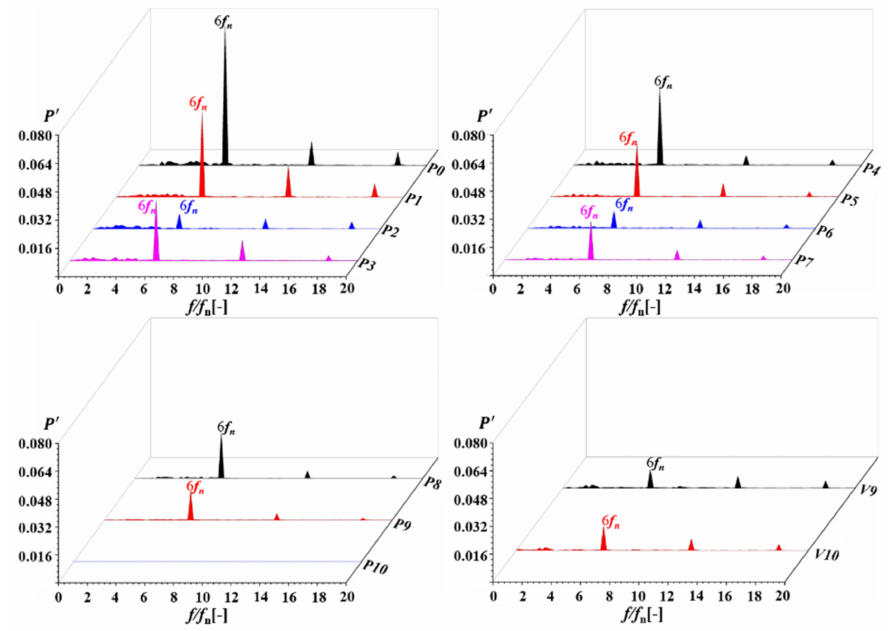
Figure 17. Frequency domain of pressure fluctuation at the Q b operation